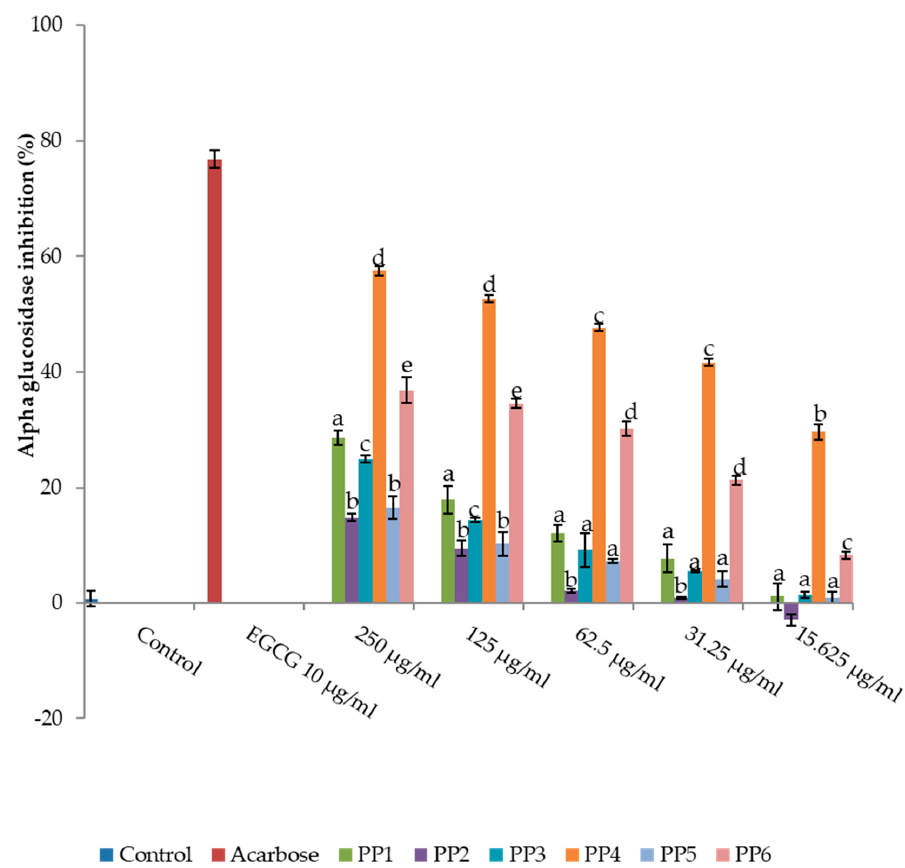
Figure 2. The inhibition of α -glucosidase by different fractions from the methanolic extract of L. tetragona . The values are expressed as mean ± SD (n = 5). Bars with different letters at each concentration are significantly different ( p < 0.05). EGCG = epigallocatechin gallate.